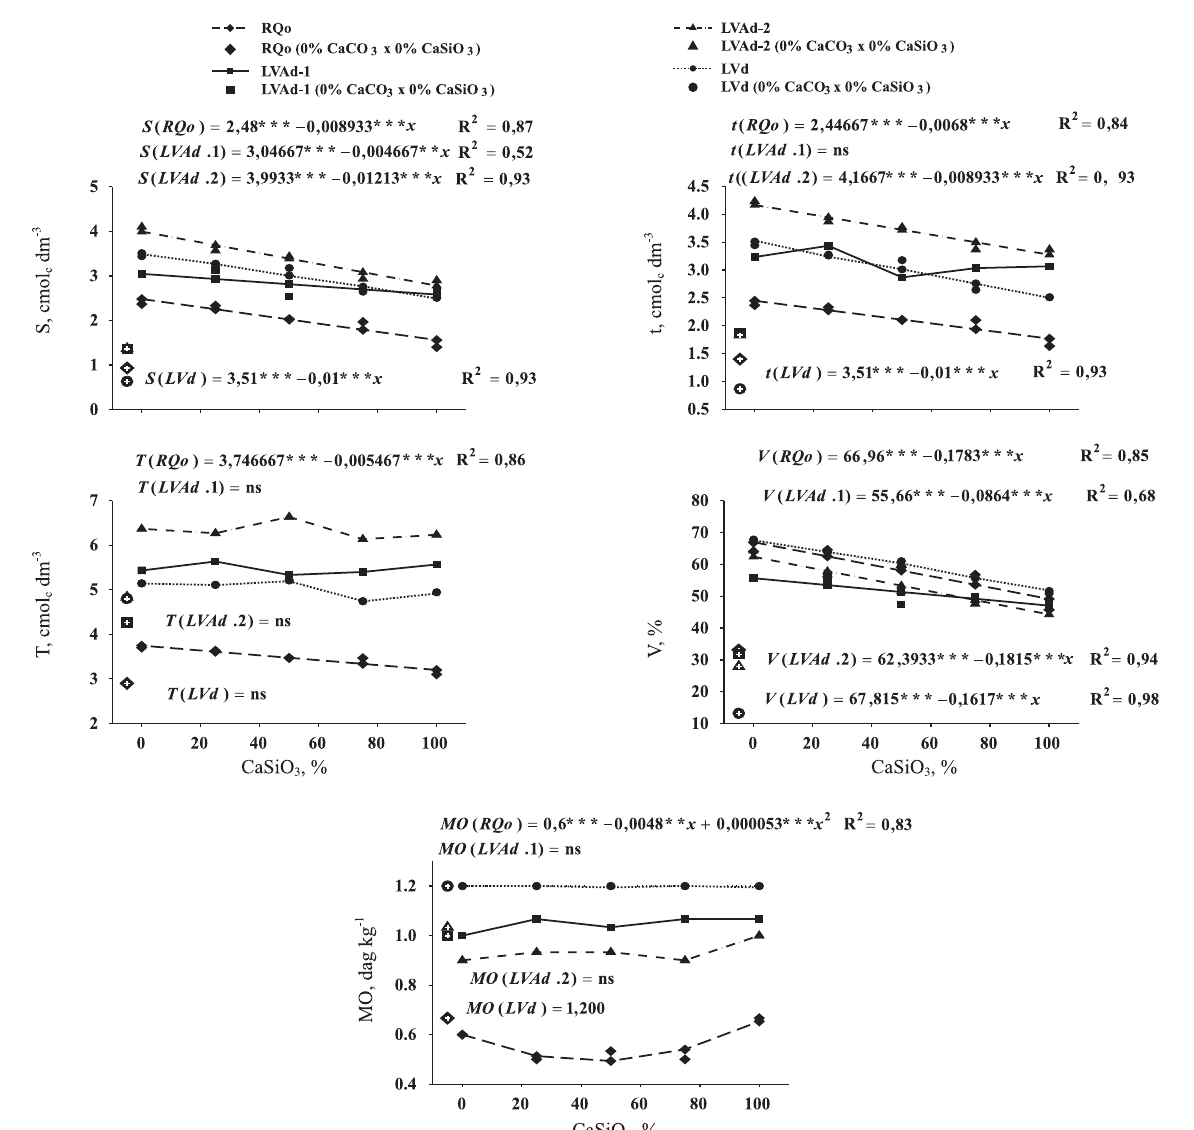
Figura 3. Influência da substituição do CaCO LVAd-1, LVAd-2 e LVd e solos sem correção. ***, **, * e ns: significativo a 0,1; 1 e 5 % e não-significativo,